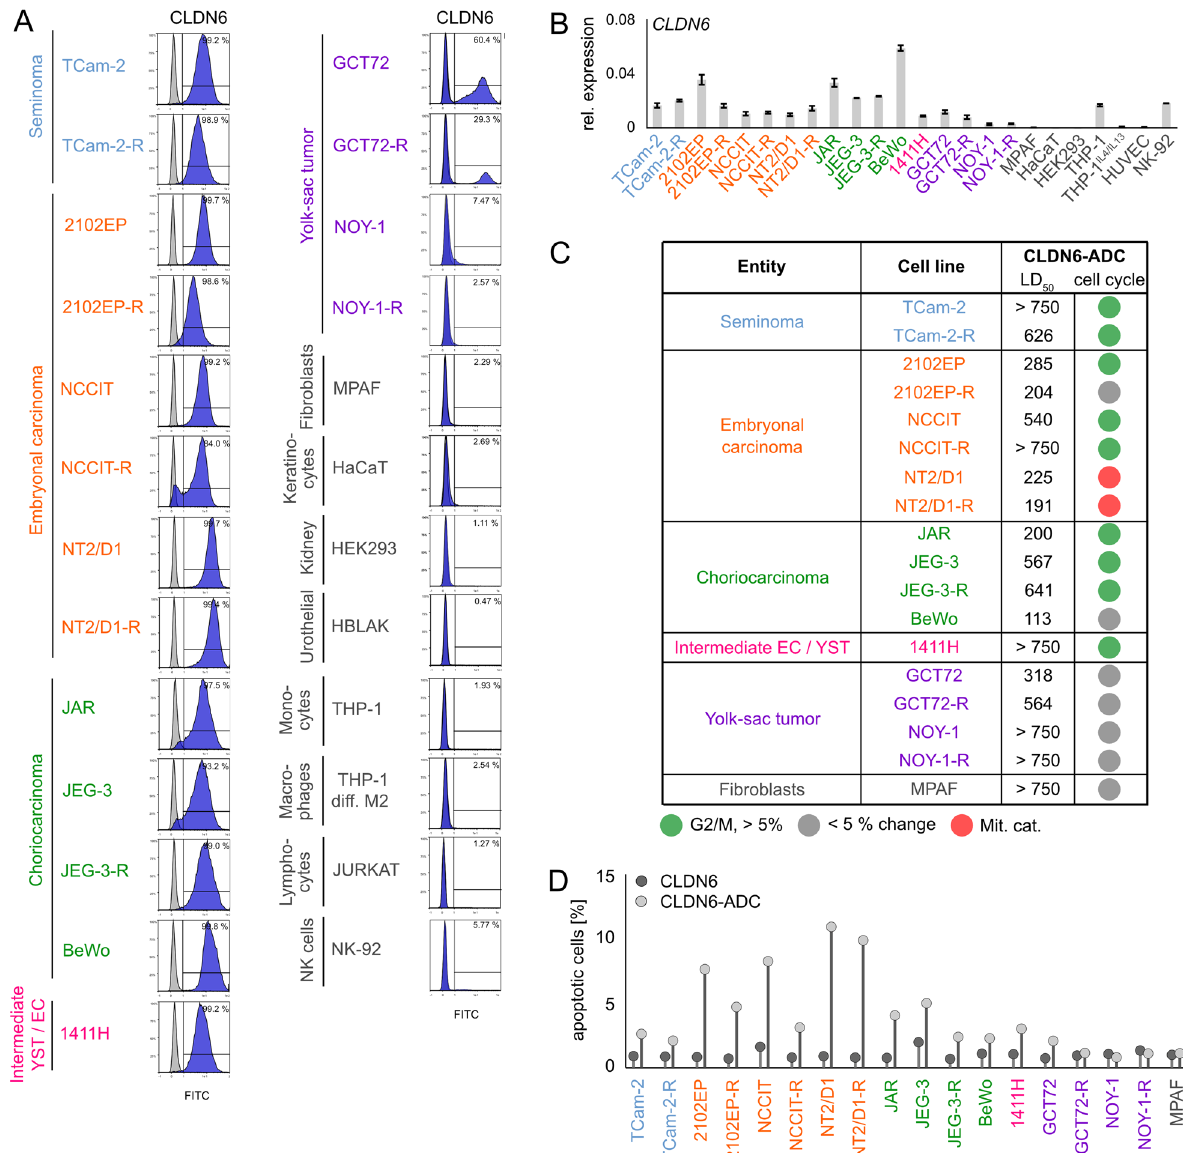
Fig. 1 CLDN6‑ADC as a novel therapeutic option to target GCTs. A Raw flow cytometry data of CLDN6‑FITC stained (blue) GCT cell lines, including their cisplatin‑resistant sublines, and non‑cancerous control cells compared with unstained controls (grey). B Relative CLDN6 expression in GCT cell lines and non‑cancerous control cells. ACTB and GAPDH were used as housekeeping genes. C LD 50 values (ng / ml) acquired by XTT cell viability assays 72 h after treatment with CLDN6‑ADC and color‑coded changes in cell cycle distribution (G2 / M changes < 5 % grey) upon treatment with CLDN6‑ADC as compared to treatment with the CLDN6 antibody alone in GCT cell lines, including their = cisplatin‑resistant sublines, as well as fibroblast control cells (MPAF). D Lollipop graph summarizing relative number of apoptotic cells in GCT cell lines and fibroblast control cells after treatment with either CLDN6‑ADC or CLDN6 antibody